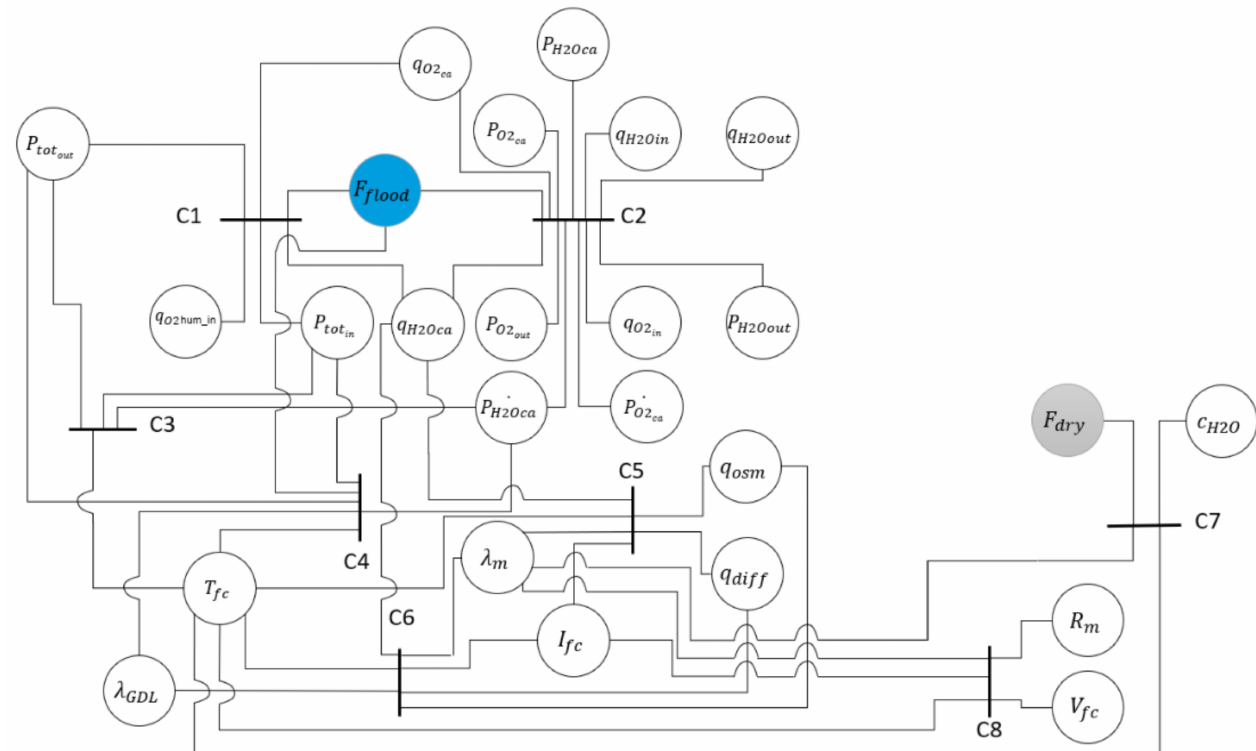
Figure 8. Structural graph with the membrane drying out